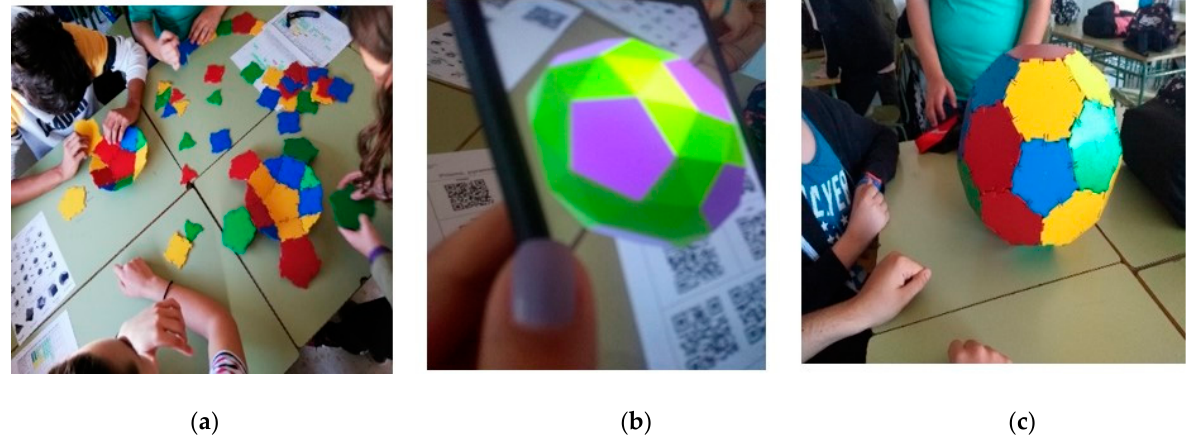
Figure 11. ( a ) student doing planes of symmetry with NeoTrie VR; ( b ) student doing planes of symmetry with manipulative materials; ( c ) dual solid hexahedron-octahedron made with NeoTrie VR by students.